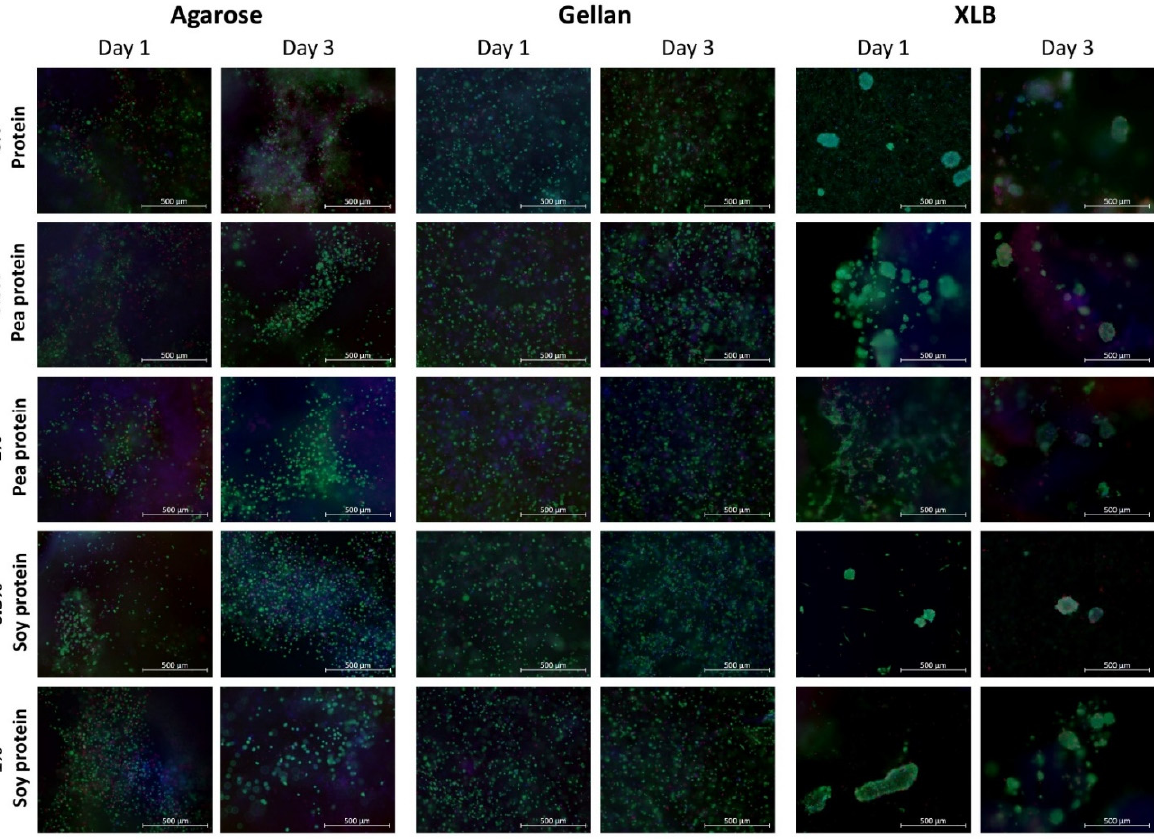
Figure 6. Live/Dead-staining of encapsulated C2C12 cells in agarose, gellan and XLB protein blended hydrogels (0%, 0.5% and 1% pea or soy protein) after one day and three days of culture. Green: viable cells; red: dead cells; blue: DNA/cell nuclei. Scale bar: 500 µm.